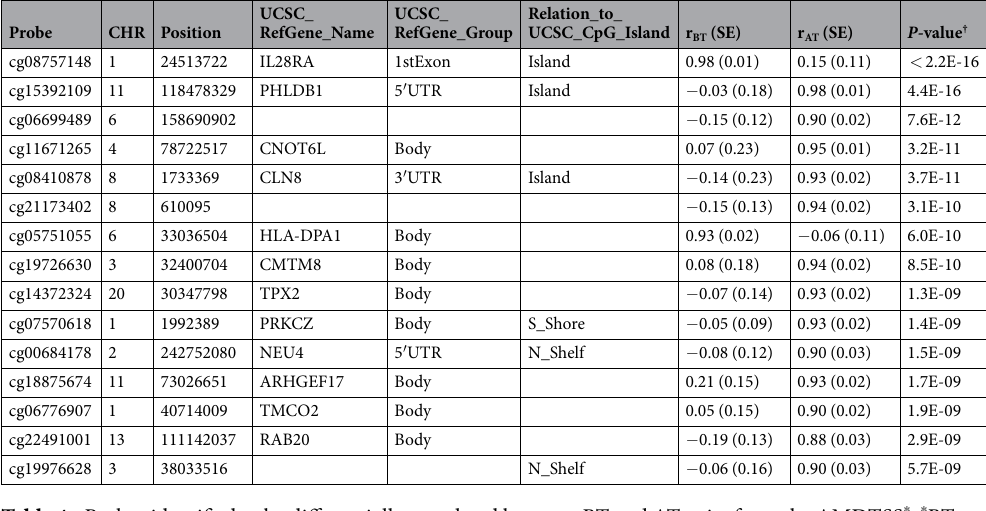
Table 4. Probes identified to be differentially correlated between BT and AT pairs from the AMDTSS * . * BT: before twin birth; AT: after twin birth; AMDTSS: Australian Mammographic Density Twins and Sisters Study; CHR: chromosomes; SE: standard error. † P -value for the comparison between r BT and r AT